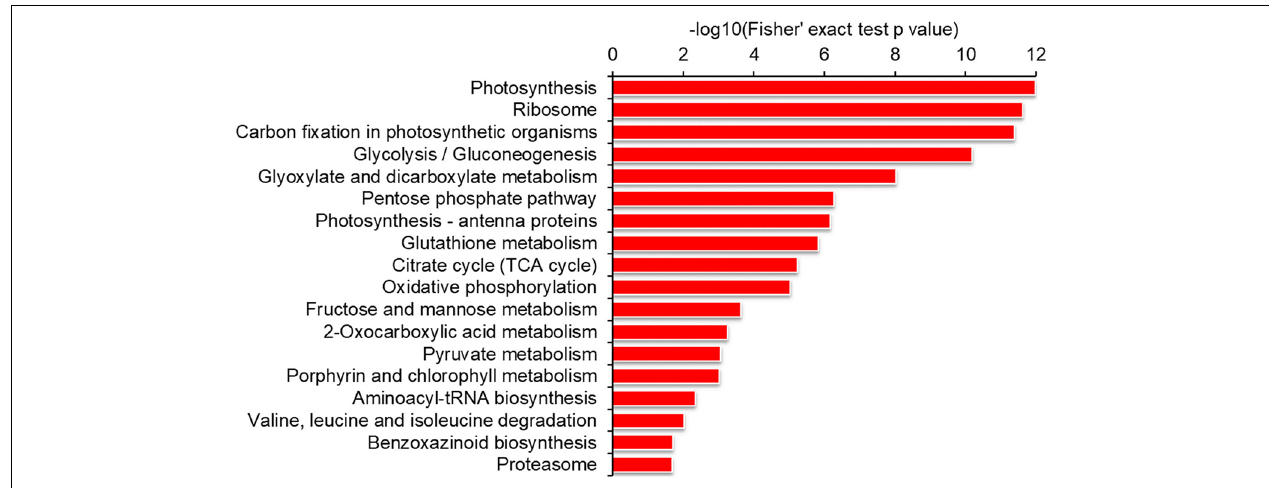
FIGURE 4 | Enrichment analysis of the modified proteins based on KEGG pathway in maize.